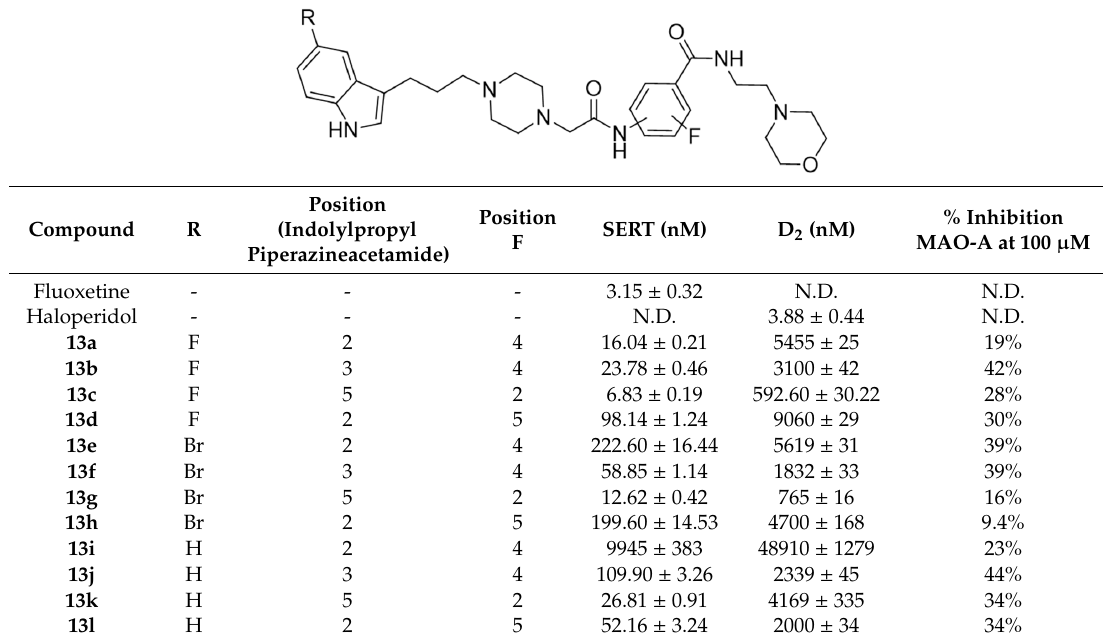
Table 2. Affinities, measured as K i values at SERT, D 2 receptor, and percent of MAO-A inhibition (at